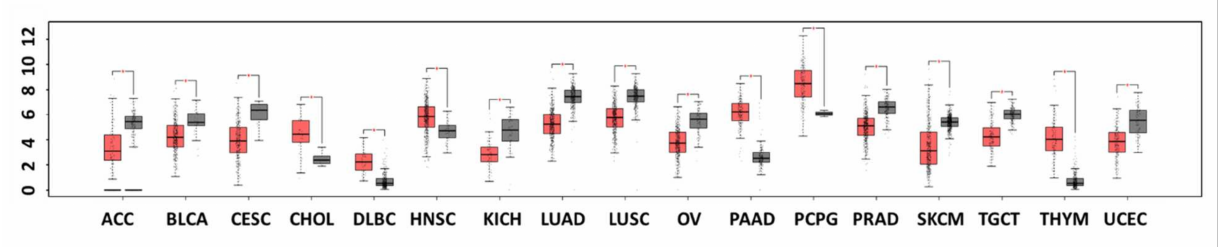
Figure 4. Differential DKK3 expression in cancer versus normal cells using RNA-Seq analysis of 9736 tumors and 8587 normal samples from TCGA and GTEx. ACC; Adrenocortical carcinoma (num(T) = 77; num(N) = 128), BLCA; Bladder Urothelial Carcinoma (num(T) = 404; num(N) = 28), CESC; Cervical squamous cell carcinoma and endocervical (num(T) = 306; num(N) = 13), CHOL; Cholangiocarcinoma (num(T) = 36; num(N) = 9), DLBC; (num(T) = 47; num(N) = 337), HNSC; Head and Neck squamous cell carcinoma (num(T) = 519; num(N) = 44), KICH; Kidney Chromo- phobe (num(T) = 66; num(N) = 53), LUAD; Lung adenocarcinoma (num(T) = 483; num(N) = 347), LUSC; Lung squamous cell carcinoma (num(T) = 486; num(N) = 338), OV; Ovarian serous cys- tadenocarcinoma (num(T) = 426; num(N) = 88), PAAD; Pheochromocytoma and Paraganglioma Thymoma (num(T) = 179; num(N) = 171), PCPG; (num(T) = 182; num(N) = 3), PRAD; Prostate adenocarcinoma (num(T) = 492; num(N) = 152), SKCM; Skin Cutaneous Melanoma (num(T) = 461; num(N) = 558), TGCT; Testicular Germ Cell Tumors (num(T) = 137; num(N) = 165), THYM; Thy- roid carcinoma (num(T) = 118; num(N) = 339), UCEC; Uterine Corpus Endometrial Carcinoma (num(T) = 174; num(N) = 91). The data were prepared using http://gepia.cancer-pku.cn (accessed on 10 September